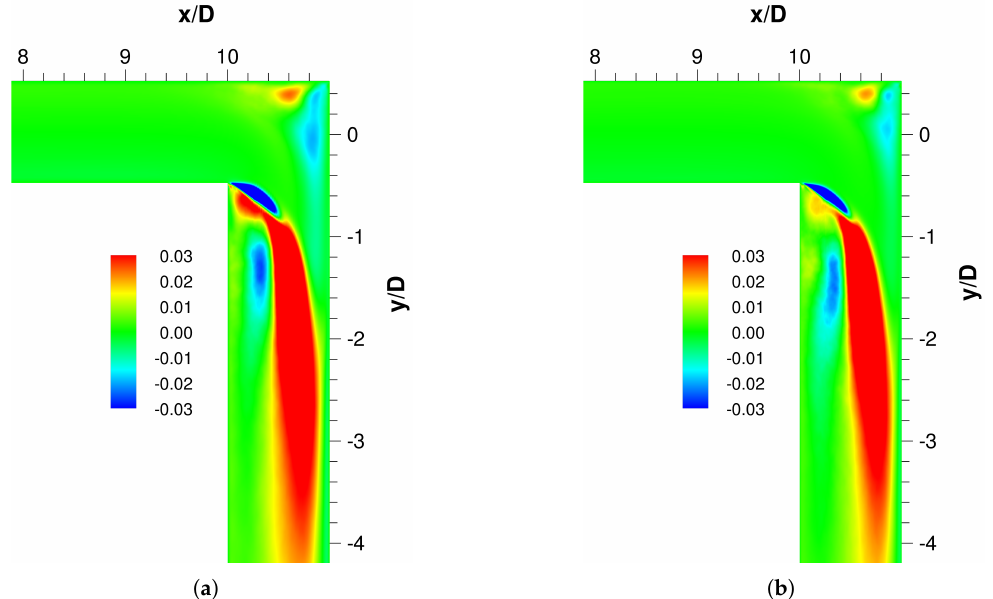
Figure 12. Time-averaged dimensionless Reynolds shear stress (cid:104) u (cid:48) v (cid:48) (cid:105) / U 2 plane at z / D = 0. ( a ) Re L . ( b ) Re H